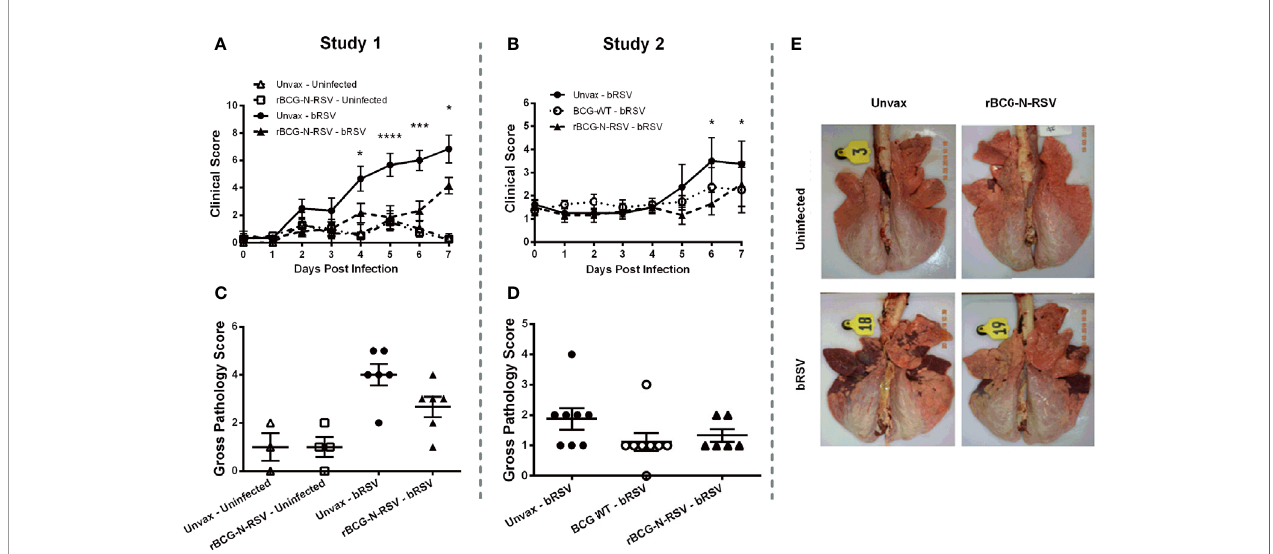
FIGURE 2 | rBCG-N-hRSV vaccination reduces bRSV-associated disease in neonatal calves. Newborn calves were vaccinated with rBCG-N-hRSV (Studies 1 and 2) or WT BCG (Study 2) and boosted 14 days after prime immunization. Fourteen days after the booster, calves were infected with BRSV strain 375 via aerosol inoculation. (A, B) Clinical Scores. Calves in all four groups were monitored daily by a blinded observer and assigned a clinical score using the criteria outlined in Materials and Methods. Data represented as mean ± SEM. *p<0.05 ***p<0.001 ****p<0.0001 as determined by 2-way ANOVA with repeated measures and Sidak ’ s multiple comparisons test (C – E) Gross Pathology Scores. All animals were humanely euthanized on day 7 post-infection. The extent of gross pneumonic consolidation was evaluated based upon the percent of lung affected (0=free of lesions; 1 = 1-5% affected; 2 = 5-15% affected; 3 = 15-30% affected; 4 = 30-50% affected; 5 = >50% affected). Aggregate gross pathology results from all groups and all animals from Study 1 and 2 are depicted in (C, D) , respectively. Data represented as mean ± SEM. No statistically signi fi cant differences were observed. (E) Representative images from one animal from each group from Study